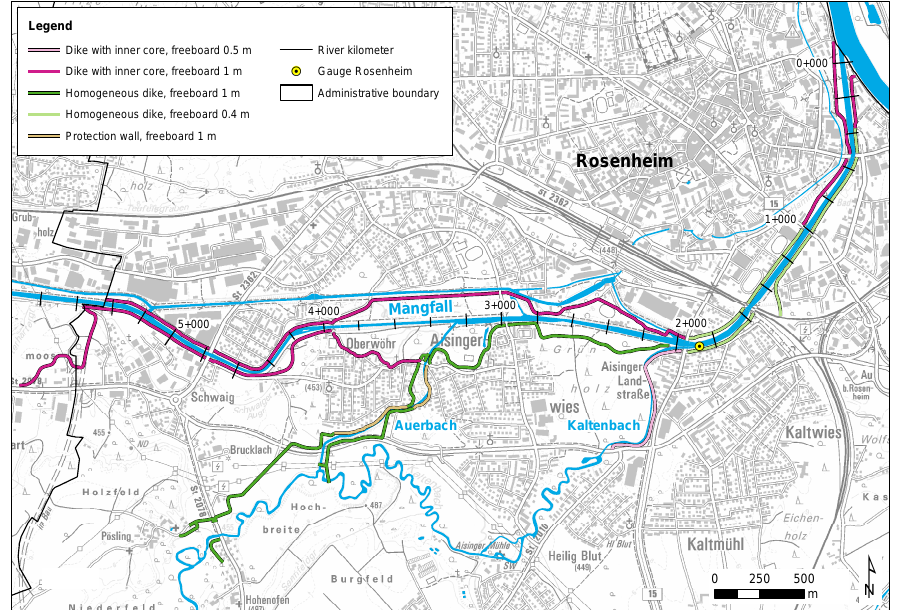
Figure 5. Protection system 2020 (S1) along the Mangfall River and the creeks Auerbach and Kaltenbach in the municipal area of Rosenheim (Data source: Geobasisdaten © Bayerische Vermessungsverwaltung, www.geodaten.bayern.de, last access: 5 May 2018).